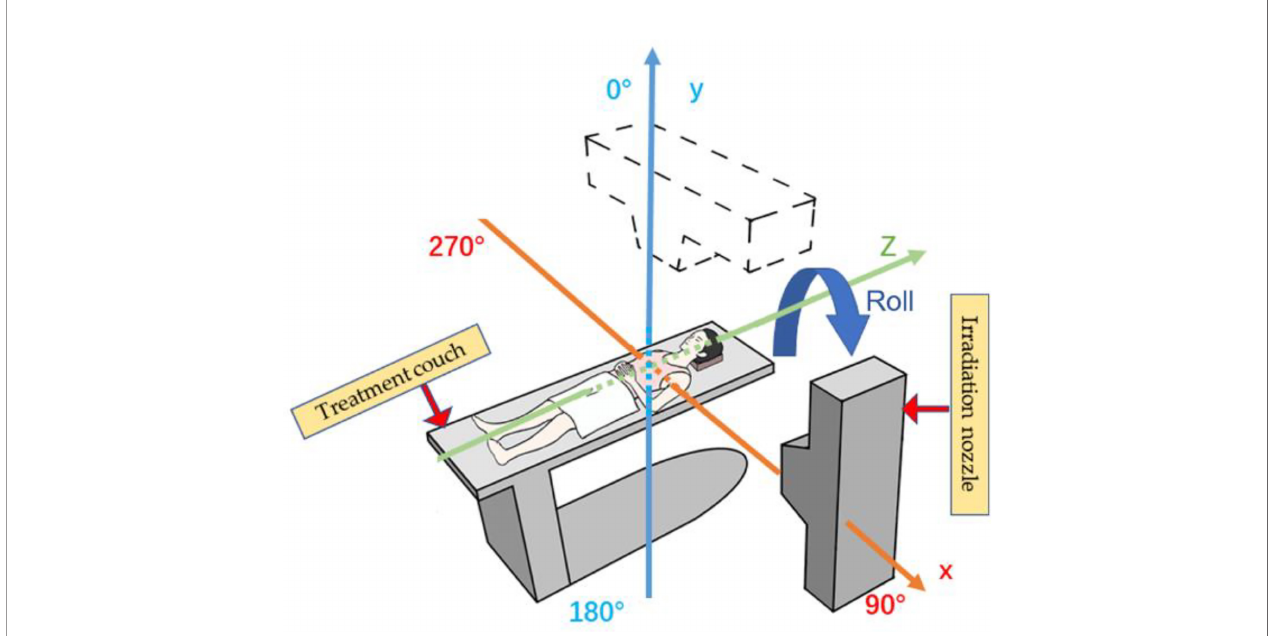
FIGURE 2 | Reference axis for beam angles mentioned in this article. The patient ’ s anterior direction is de fi ned as 0° (supine position). The orange line shows the X-axis, and the blue line shows the Y-axis; the irradiation angle is clockwise.